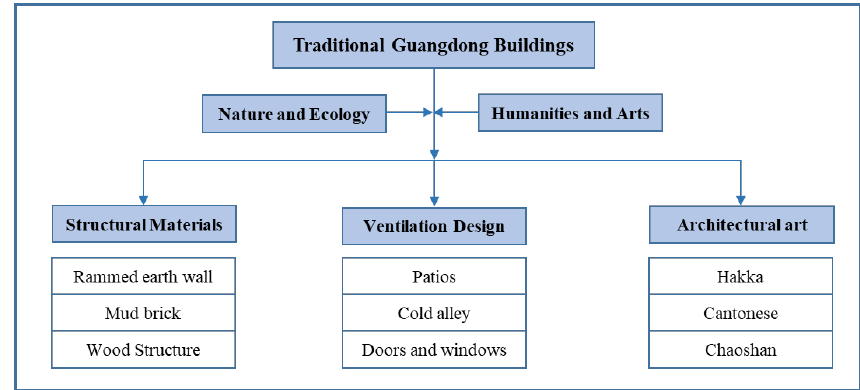
Figure 2. Structure of the article.